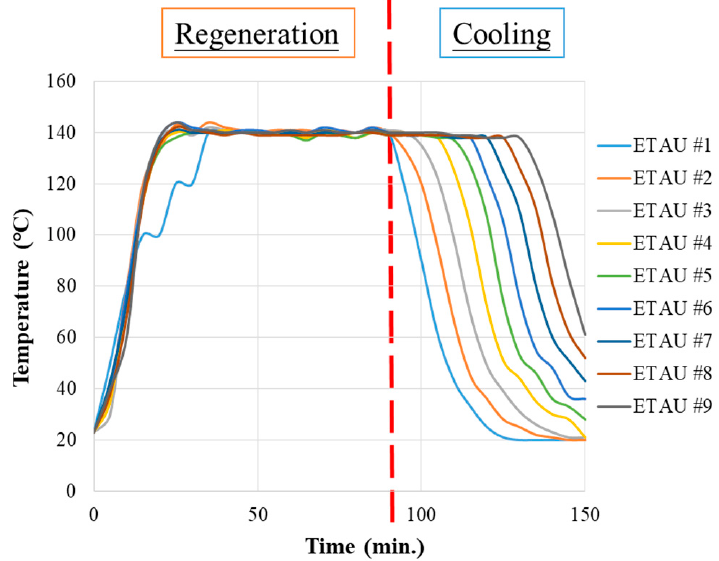
14 of 18 Figure 15. System configuration of an ETAU compressed air dryer: ( a ) regeneration, ( b ) cooling, ( c ) and adsorption steps in tower A. In contrast to conventional heating practices, the ETAU directly heats the adsorbent by using an electrothermal metal; therefore, if the system uses copious regeneration flow, the adsorbent is cooled. However, desorption vapors from the adsorbent cannot move out